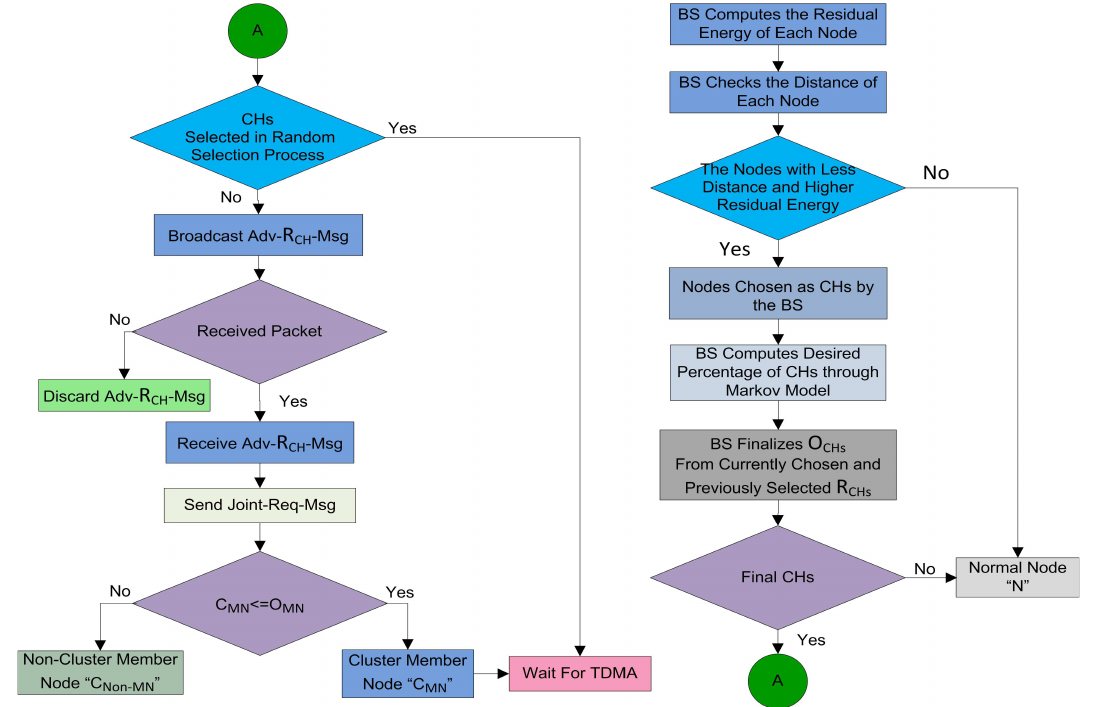
Figure 7. The optimal CHs selection on the basis of residual energy and distance Via BS